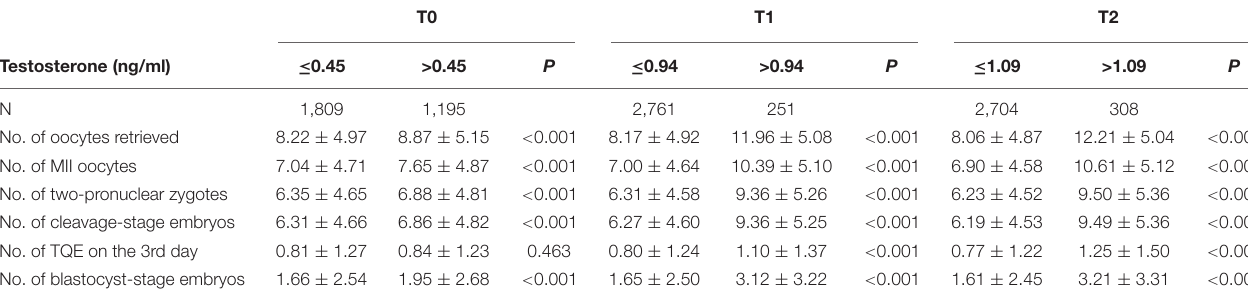
TABLE 4 | Comparisons of pregnancy outcomes between patients with T levels ≤ and > the inflection point at the three time points. T0 T1 T2 Testosterone (ng/ml) ≤ 0.45